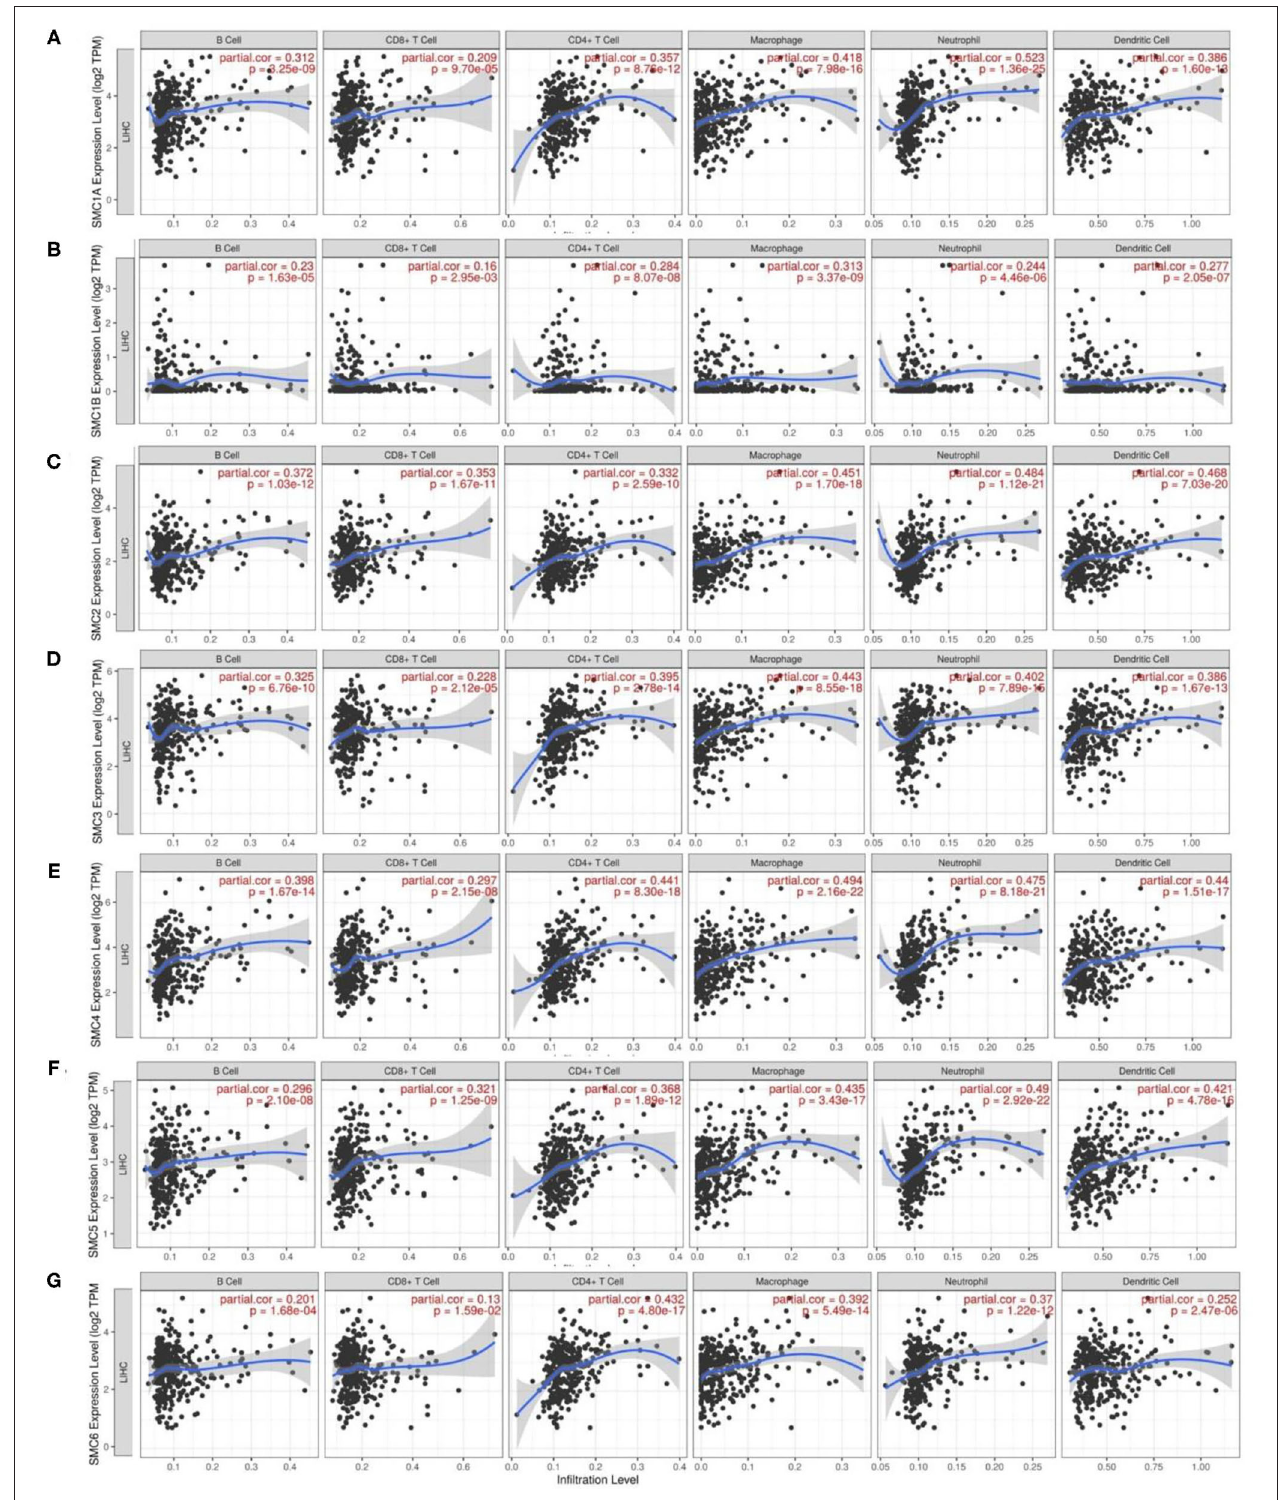
FIGURE 7 | Analysis of correlations involving the expression of SMC family genes and immune cell infiltration in HCC. (A-G) Correlation of SMC1A, SMC1B, SMC2, SMC3, SMC4, SMC5 , and SMC6 mRNA expression and the immune cell infiltration levels in HCC by the TIMER database.